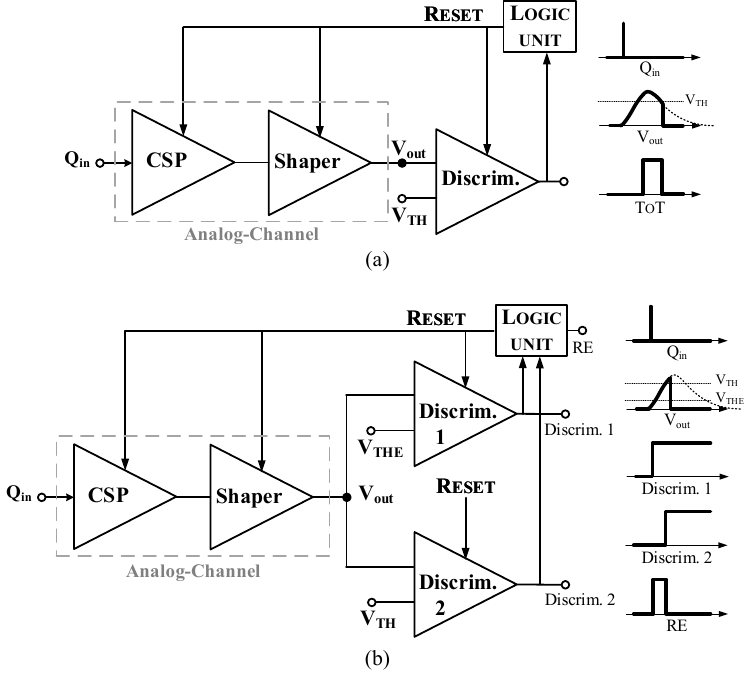
Figure 10. The simplified schematic of the ( a ) TV-ToT; and ( b ) TV-RE